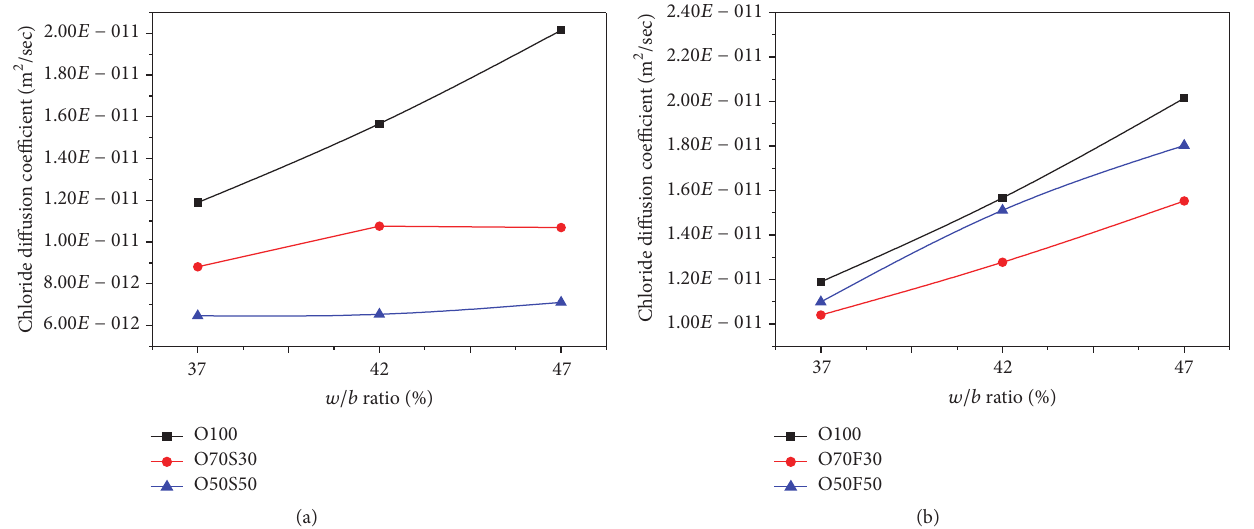
Figure 4: Chloride diffusion coefficient of HPC with (a) GGBFS and (b) FA at nonsteady state condition.